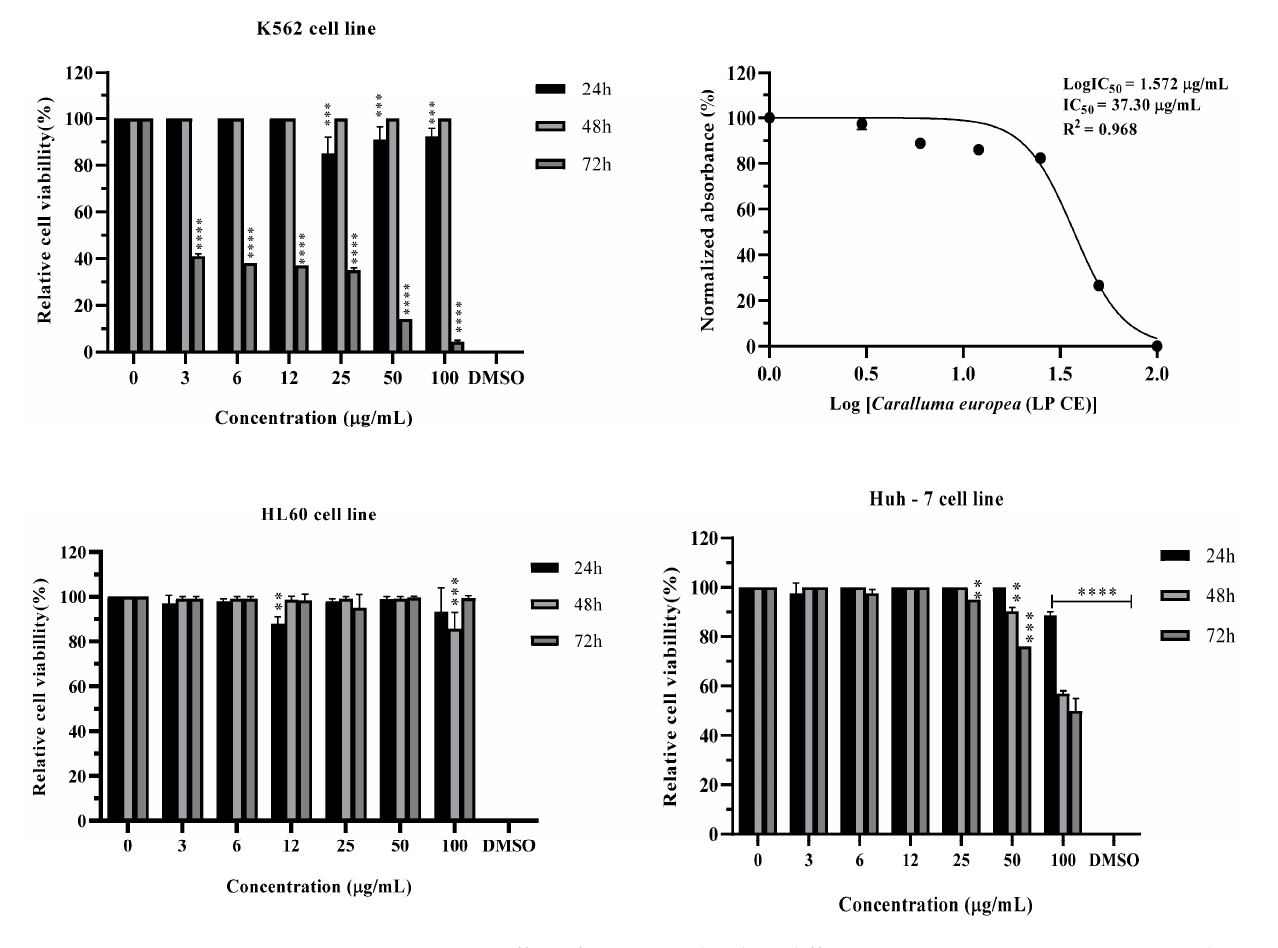
Figure 5. Cytotoxic effect of C. europaea lipids at different concentrations against HL60, Huh-7, and K562 cell lines, after 24, 48, and 72 h. The IC 50 for HL60, Huh-7, and K562 cells was evaluated using nonlinear regression (GraphPad Prism v5 software). The cell survival was assessed by the MTT test.